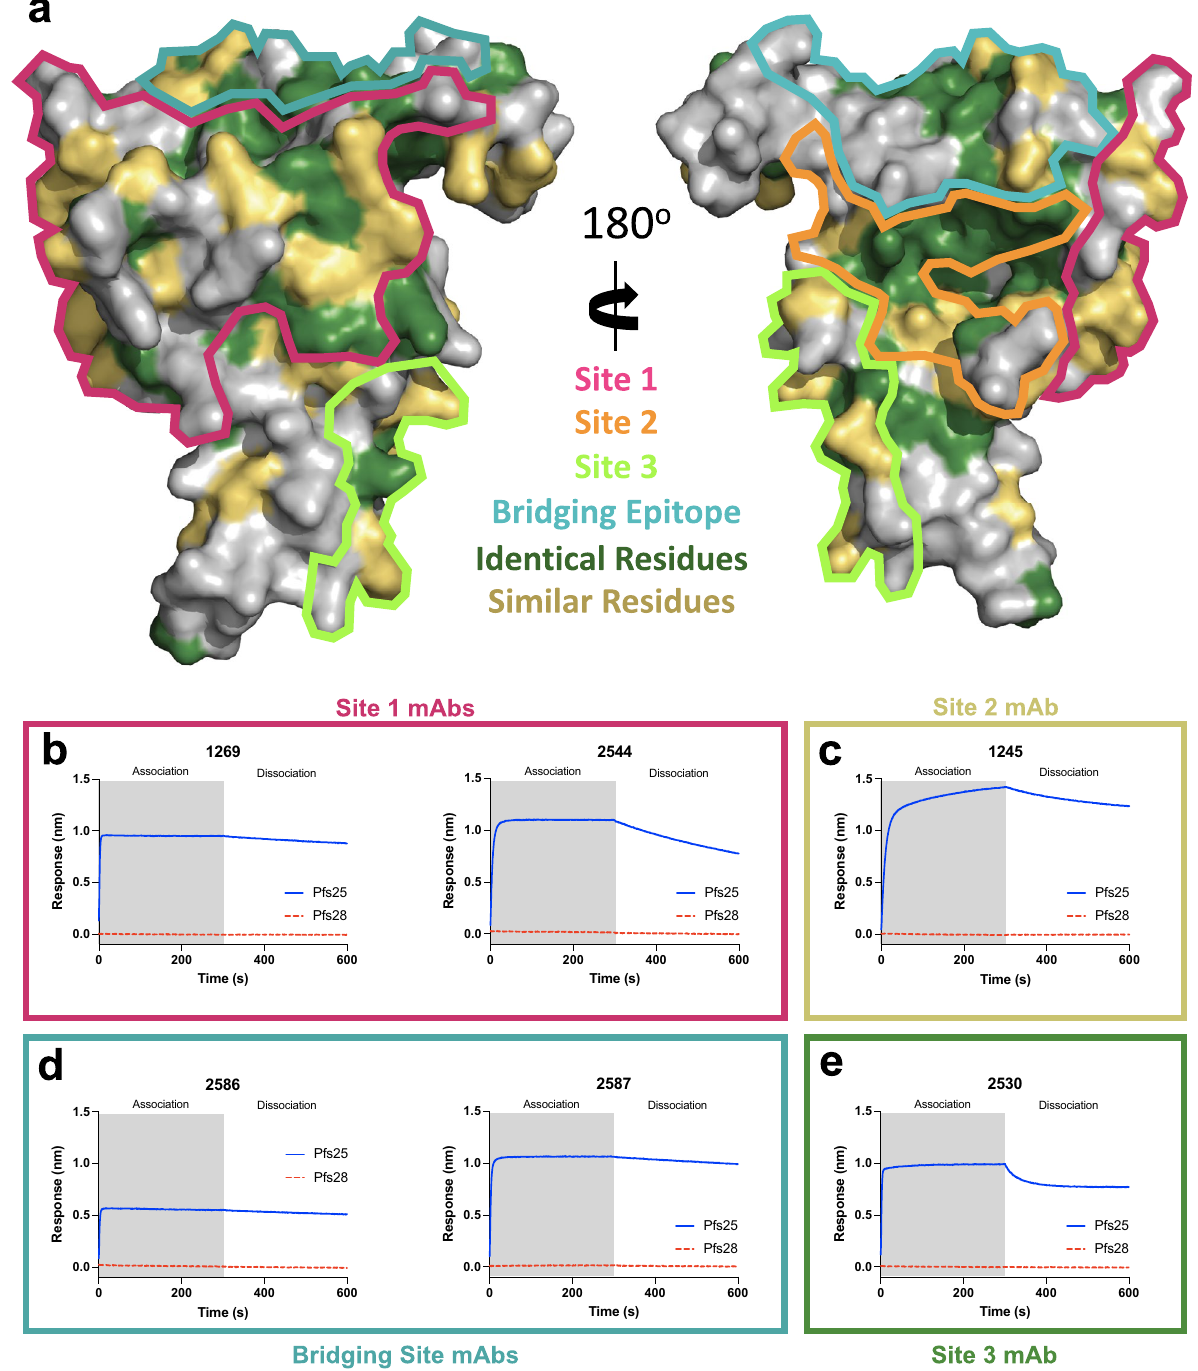
Figure 5. Pfs28 does not cross-react with anti-Pfs25 mAbs. ( a ) Structure of Pfs25 (PDB ID: 6PHB) 16 with outlined immunogenic sites 15,16 and identical and chemically similar residues to Pfs28 highlighted in green and yellow. ( b – e ) Binding curves of biolayer interferometry experiments using Pfs25 and Pfs28 and transmission reducing Pfs25 mAbs grouped by immunogenic site. Curves represent association and dissociation of each scFv (1 µM) to sensors loaded with Pfs25 (blue) or Pfs28